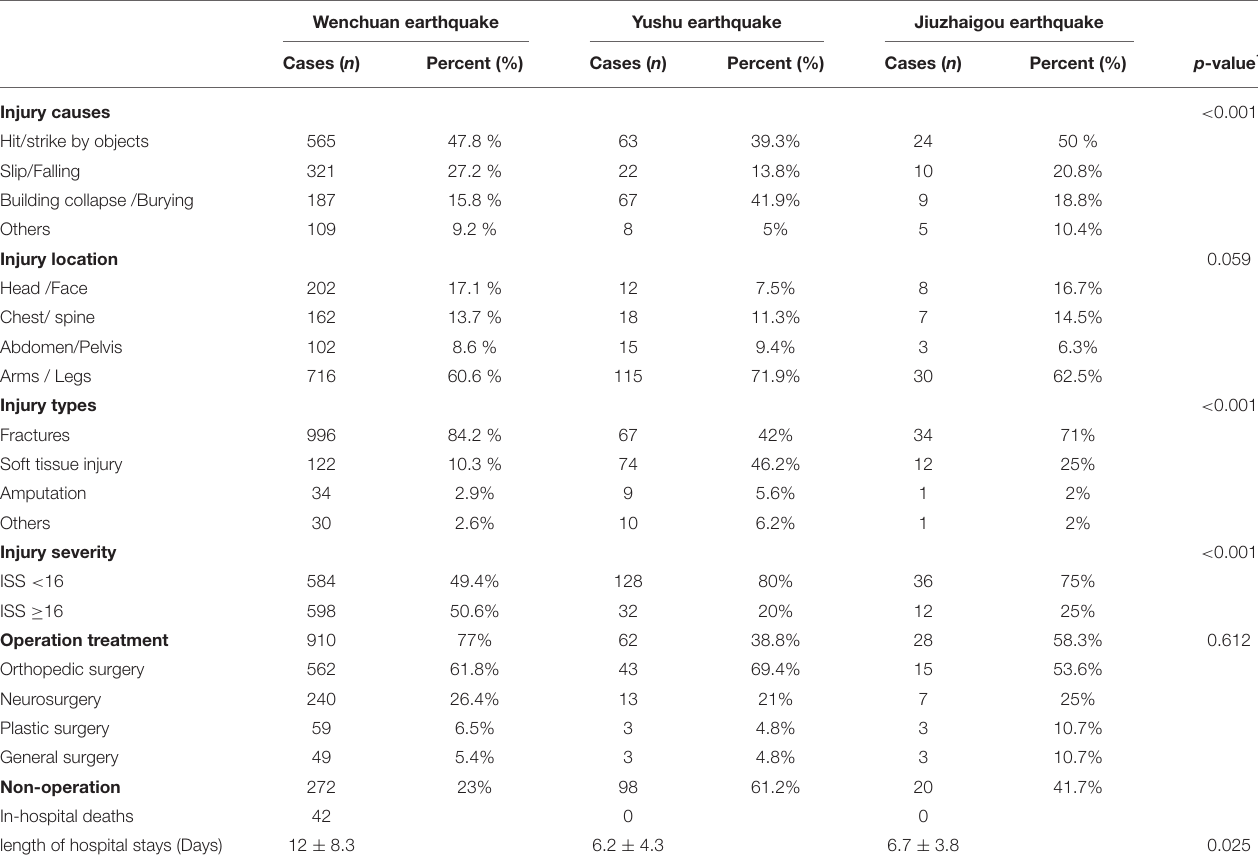
TABLE 2 | The Injury characteristics of Wenchuan, Yushu, and Jiuzhaigou earthquake patients. Wenchuan earthquake Yushu earthquake Jiuzhaigou